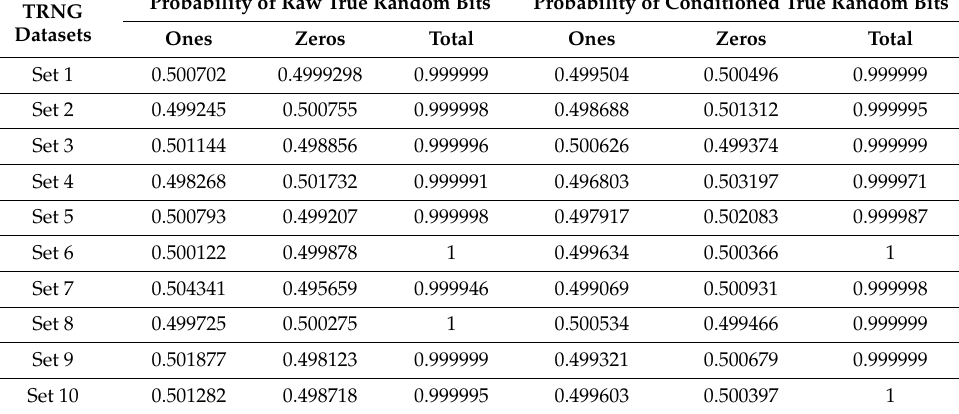
Table 2. Equidistribution analysis.